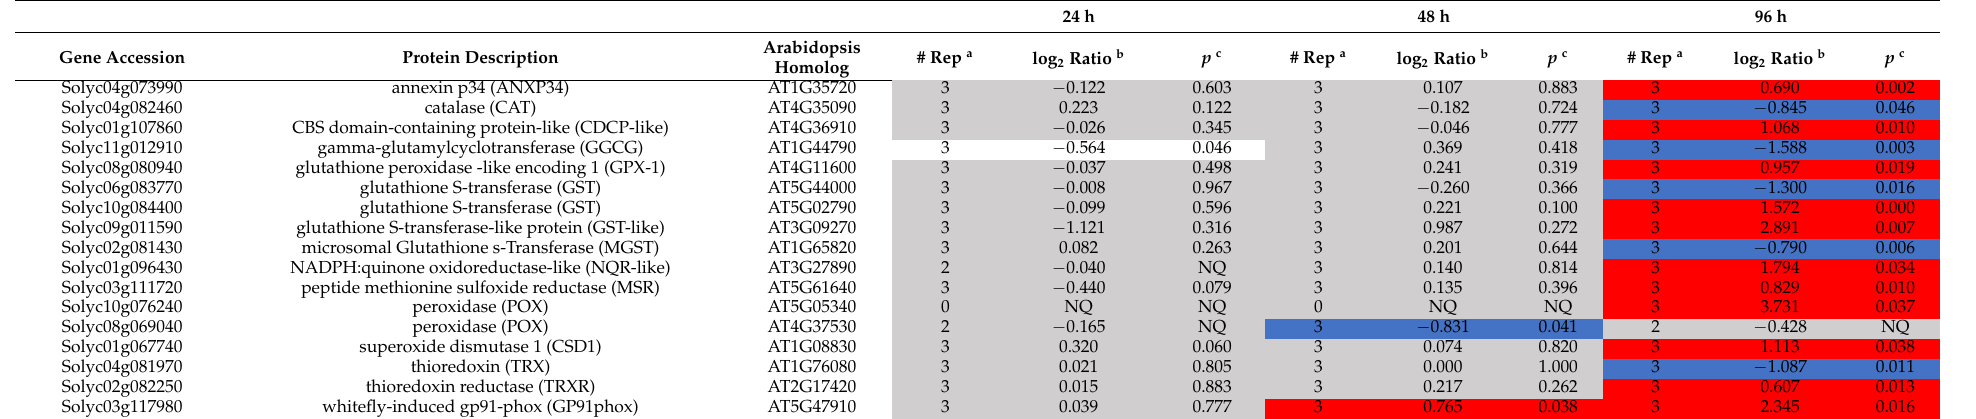
Table 4. Proteins involved in ROS homeostasis and redox regulation with a significant change in abundance at 24, 48 and 96 h post-inoculation with P. infestans